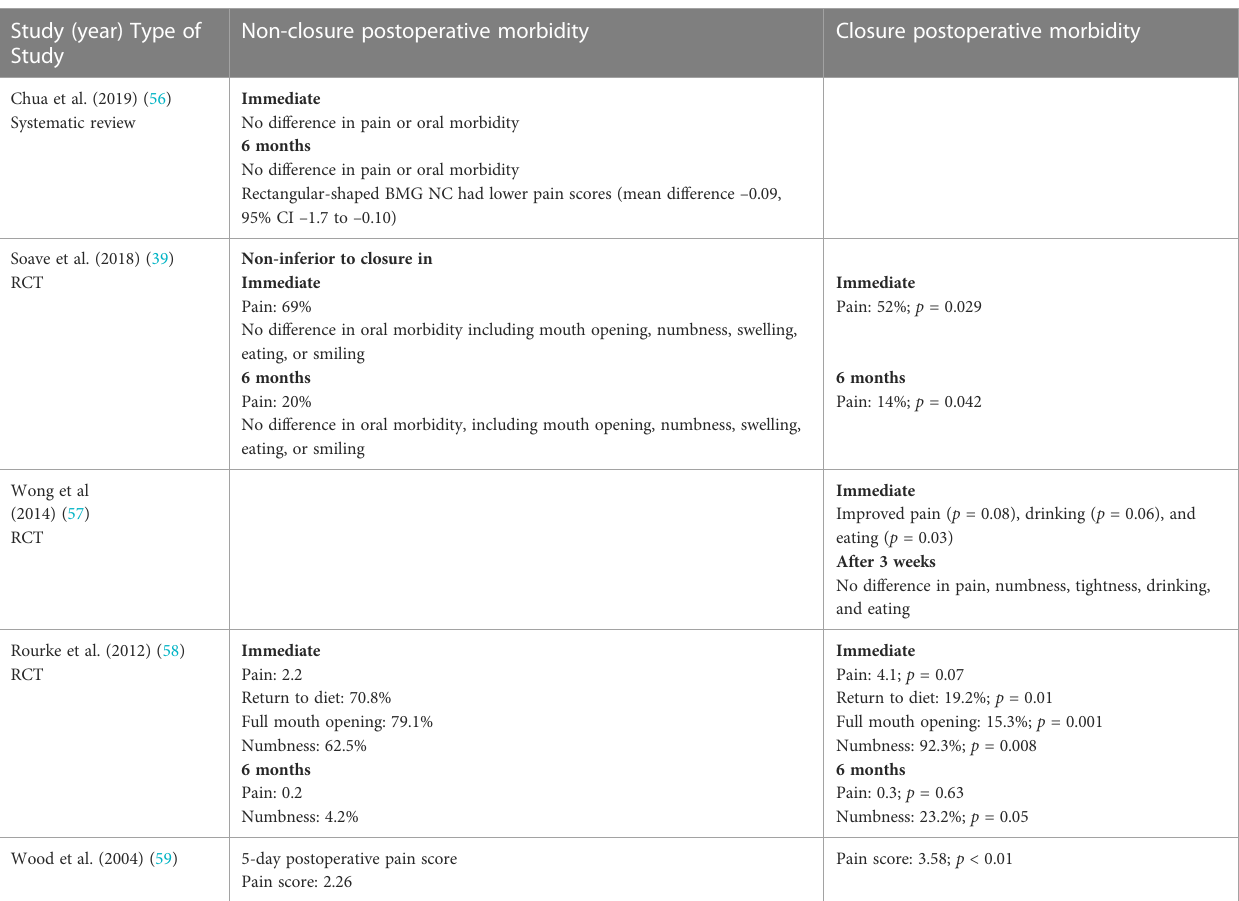
TABLE 3 Studies evaluating closure and non-closure of BMG harvest site.